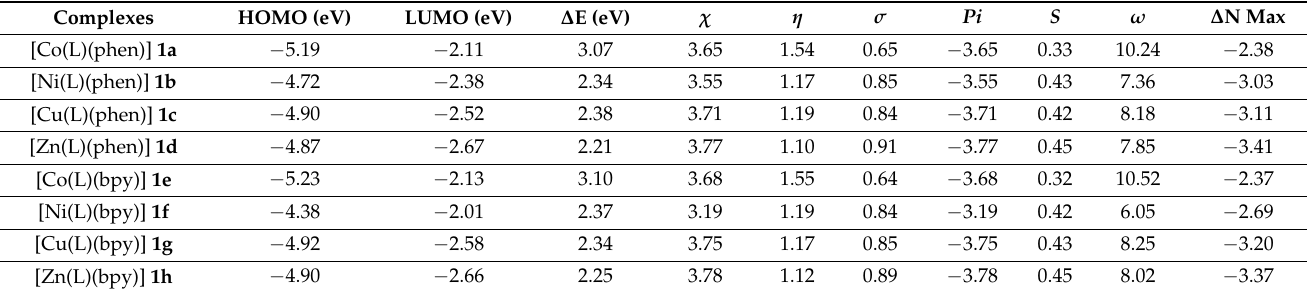
Figure 7. Frontier molecular orbitals of investigated complexes, namely, ( i ) cobalt(II) complex 1e , ( ii ) nickel(II) complex 1f , ( ii ) copper(II) complex 1g , and ( iv ) zinc(II) complex 1h , using B3LYP/LACVP ++ basis set. Table 9. The calculated quantum parameters for the metal(II) complex 1 ( a – h